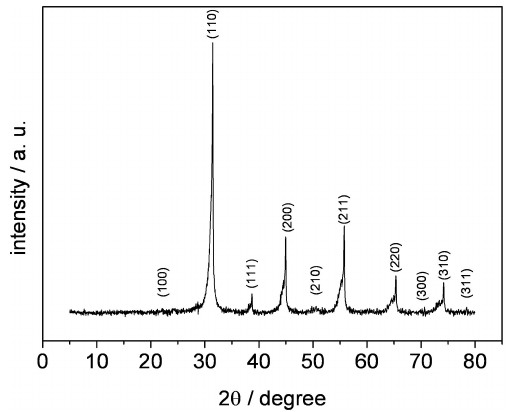
Figure 2. XRD pattern of the BFT30 powder as it was used for the ADM process.